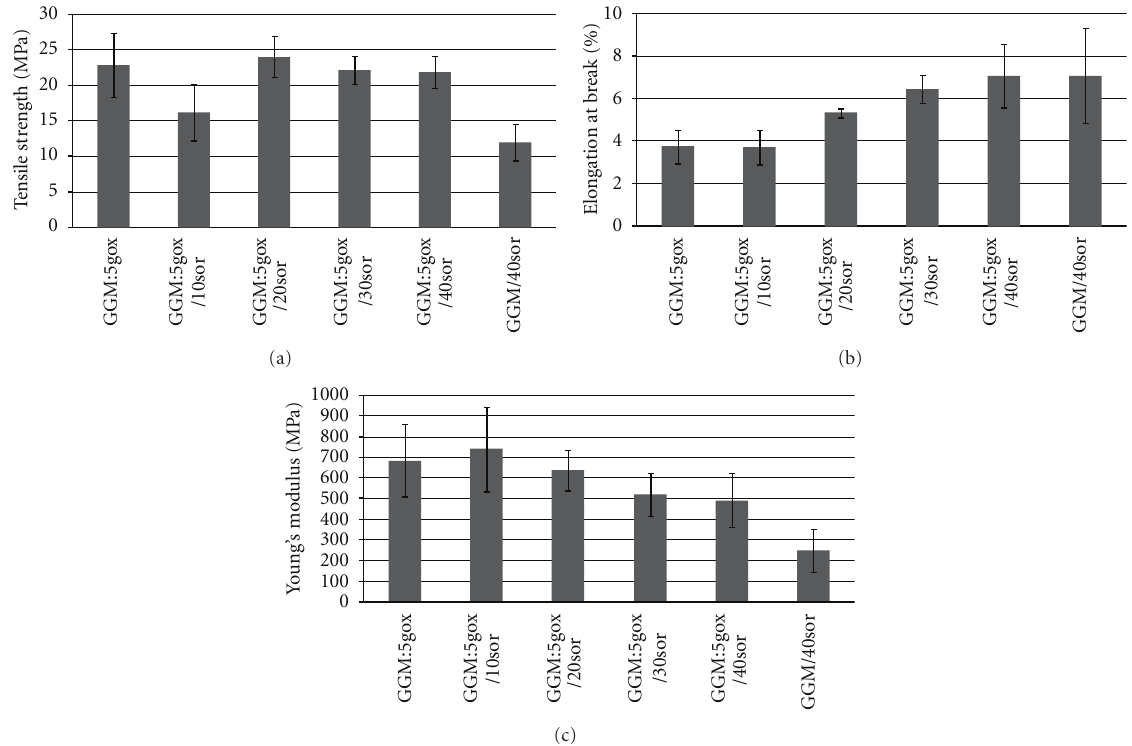
Figure 1: (a) Tensile strength, (b) elongation at break, and (c) Young’s modulus of films. The results are averages from 9 to 10 measurements, and the error bars indicate standard deviations. Sample coding as presented in Table 1.